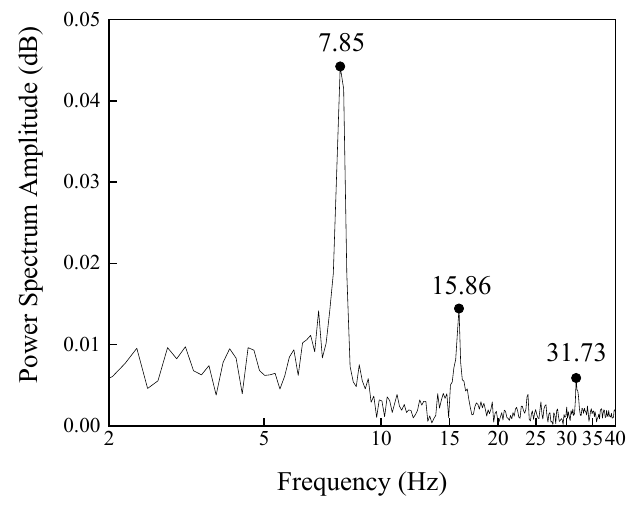
Figure 12. Modal frequencies of street sign at measured location .